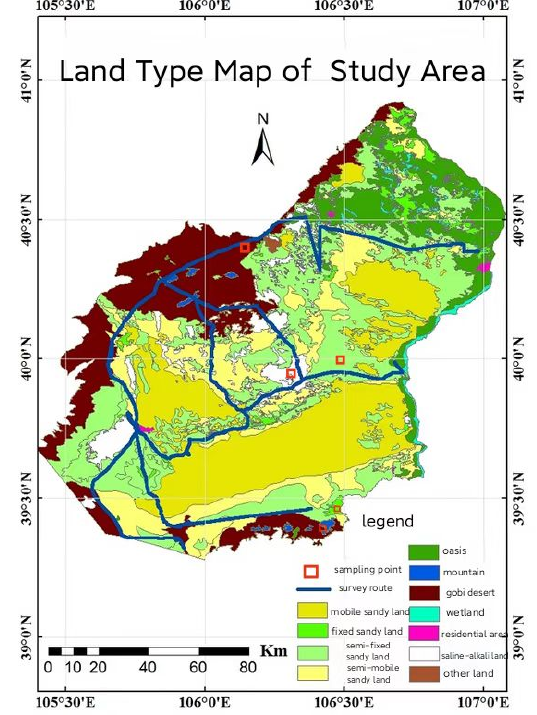
Figure 3. Study area of A. mongolicus in different habitats.